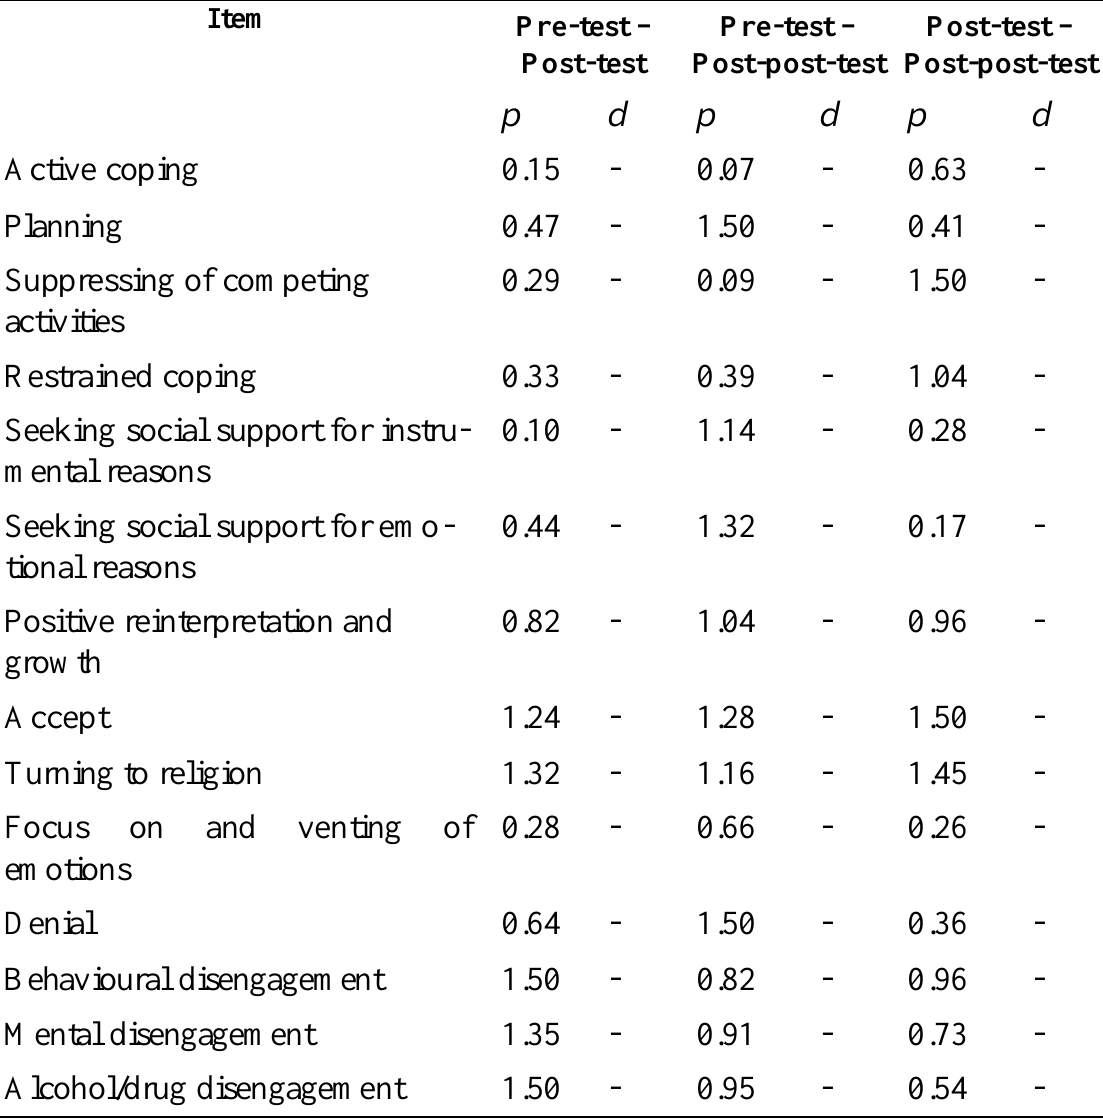
Significance of differences between the experimental and control groups on the COPE Pre-test